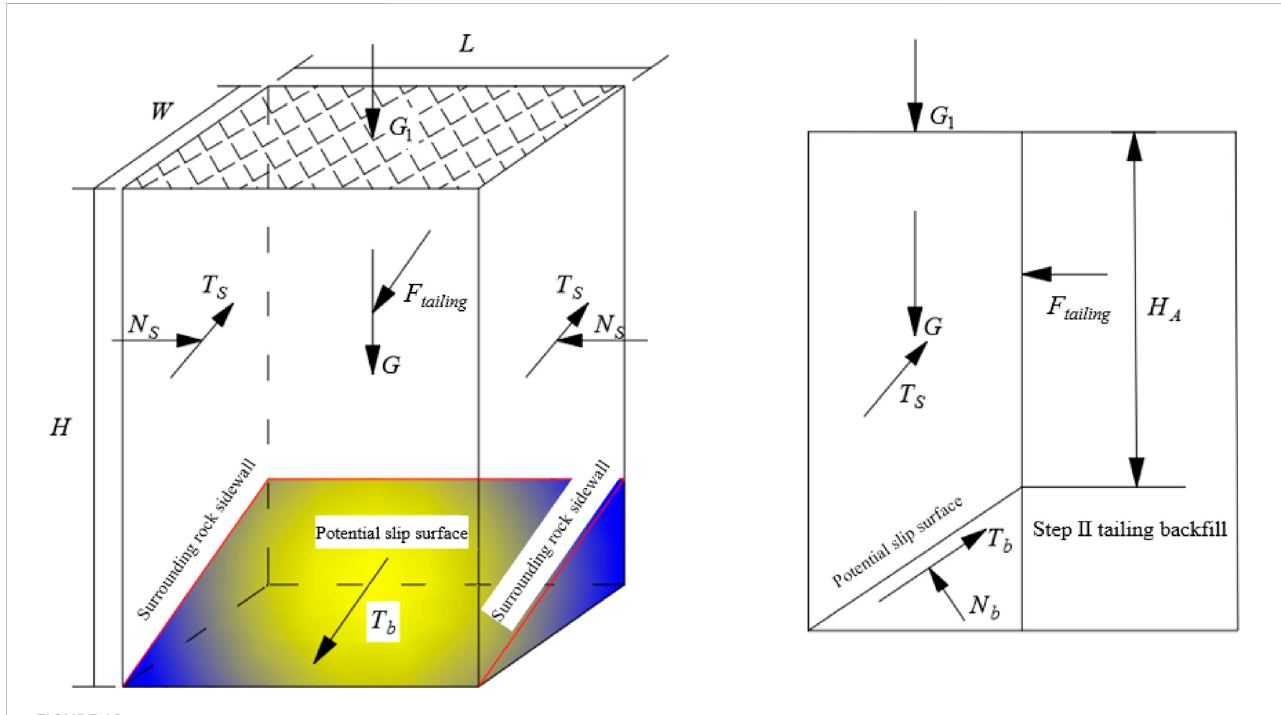
FIGURE 12 Schematic diagram of the mechanical model of I-step cemented fi